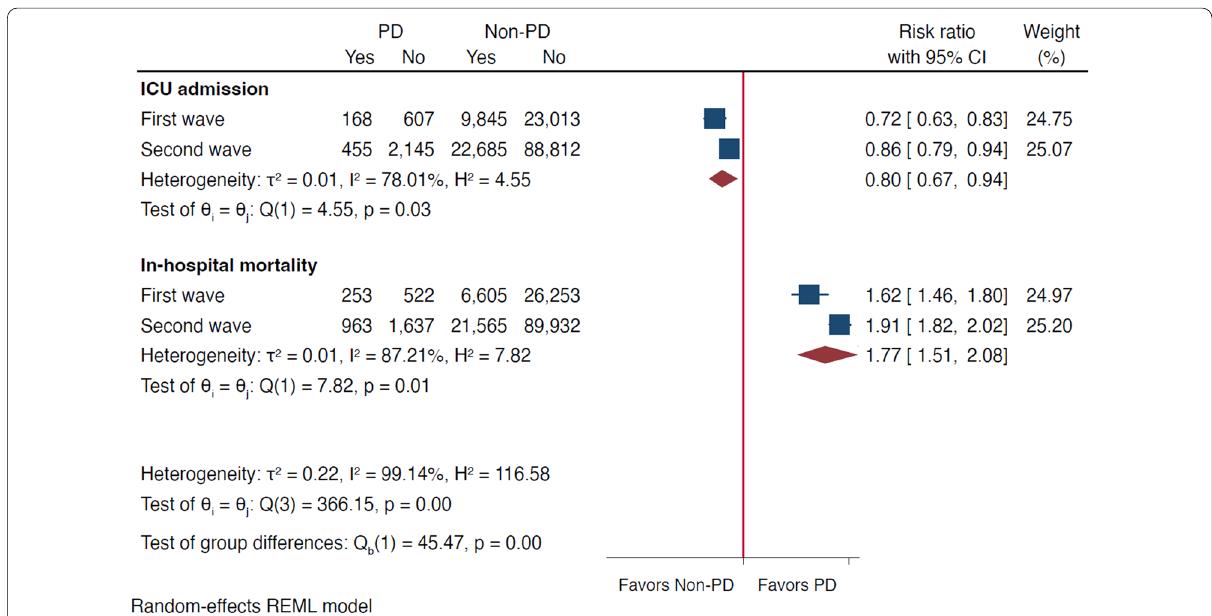
(Table 1). They more often suffered from type 2 dia- betes mellitus (applies to the second wave only), arte- rial hypertension, cardio- and cerebrovascular disease, and chronic kidney disease, and less often from obesity (Table 1).